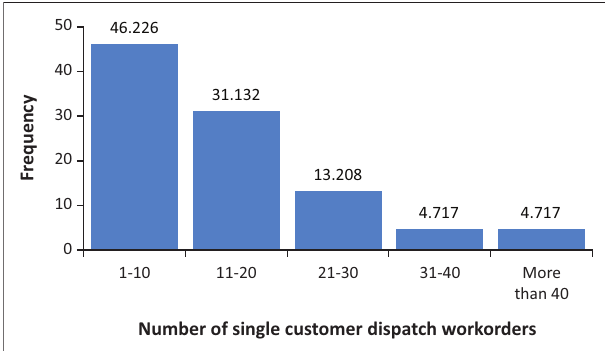
FIGURE 5: Distribution of single customer dispatch work orders received per month. Figure 5 indicates that most technicians received less than 20 single customer dispatch work orders per month, 46.226 %